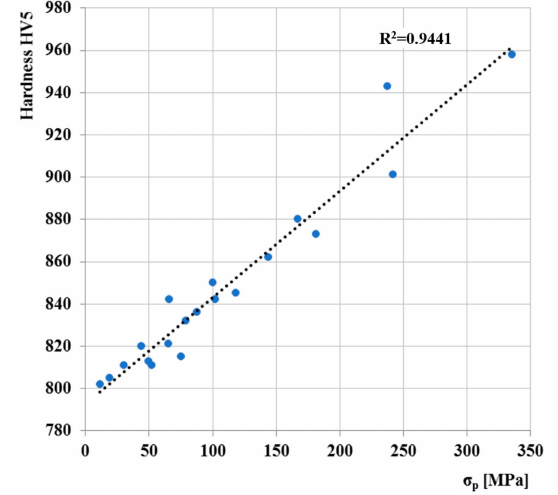
Figure 20. Total dependence of peak stress σ p on the Vickers